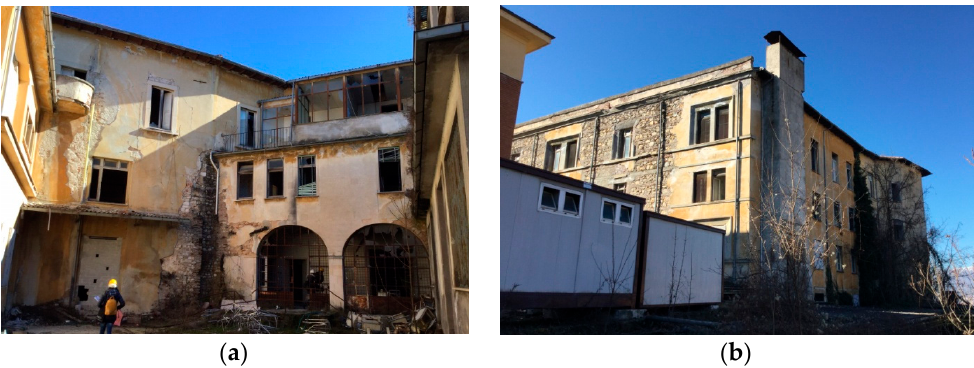
Figure 9. The current state of degradation observed in the inspection of 16 February 2016: ( a ) The court enclosed by inadequate extensions; ( b ) A view of the north face of the complex.